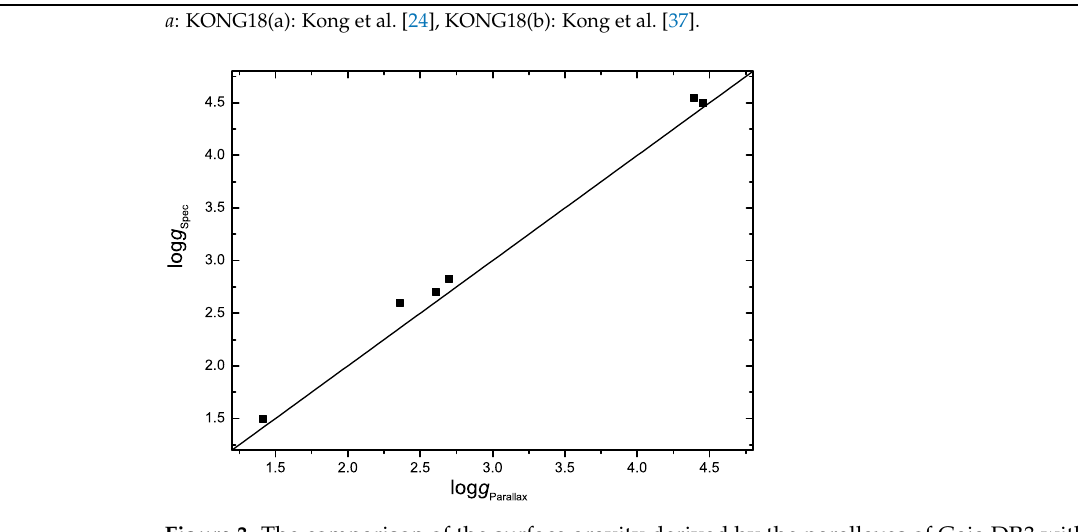
Figure 3. The comparison of the surface gravity derived by the parallaxes of Gaia DR3 with those from the spectra method in this